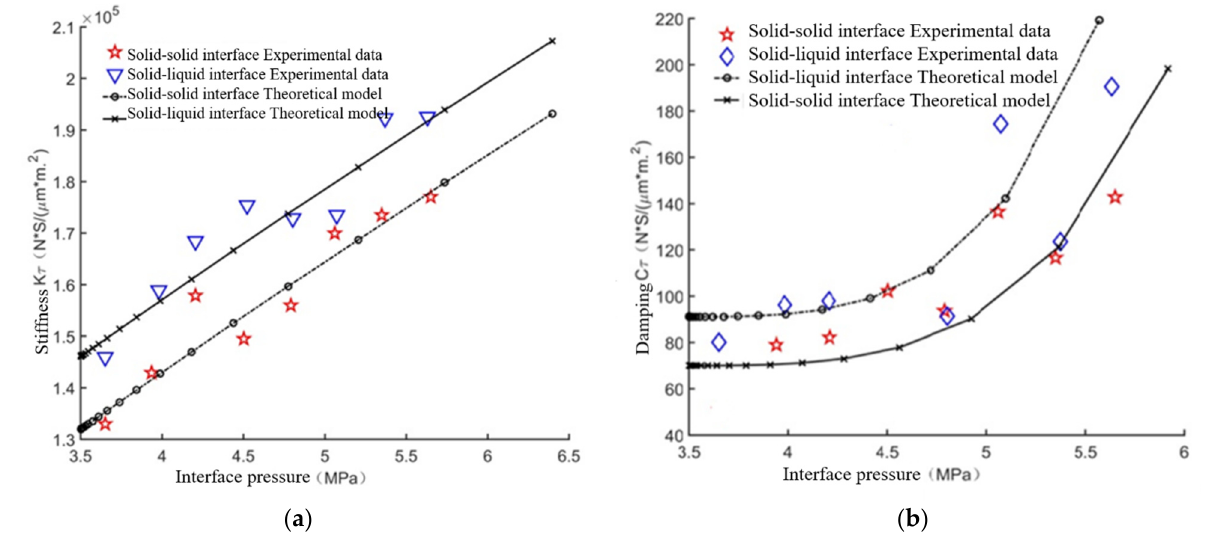
Figure 12. Comparative verification of the theoretical model and the experimental data of tangential contact stiffness and damping varying with normal load. ( a ) Tangential contact stiffness, ( b ) tangential contact damping.